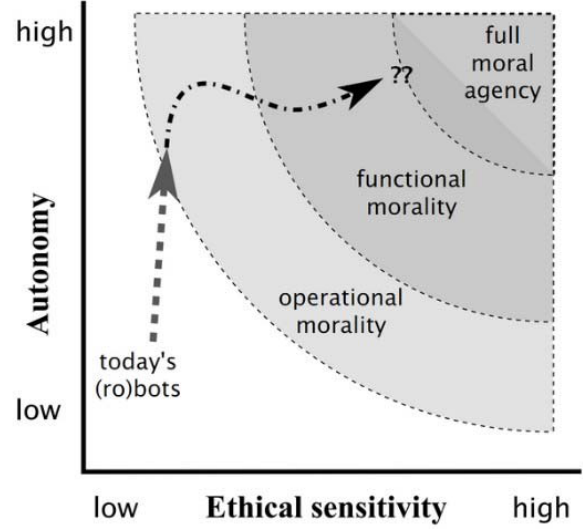
Figure 2. Levels of robot morality (operational, functional, full) embedded in the robot autonomy vs. ethical sensitivity plane. Source: www.wonderfulengineering.com/future-robots-will-have-moral-and-ethical-sense